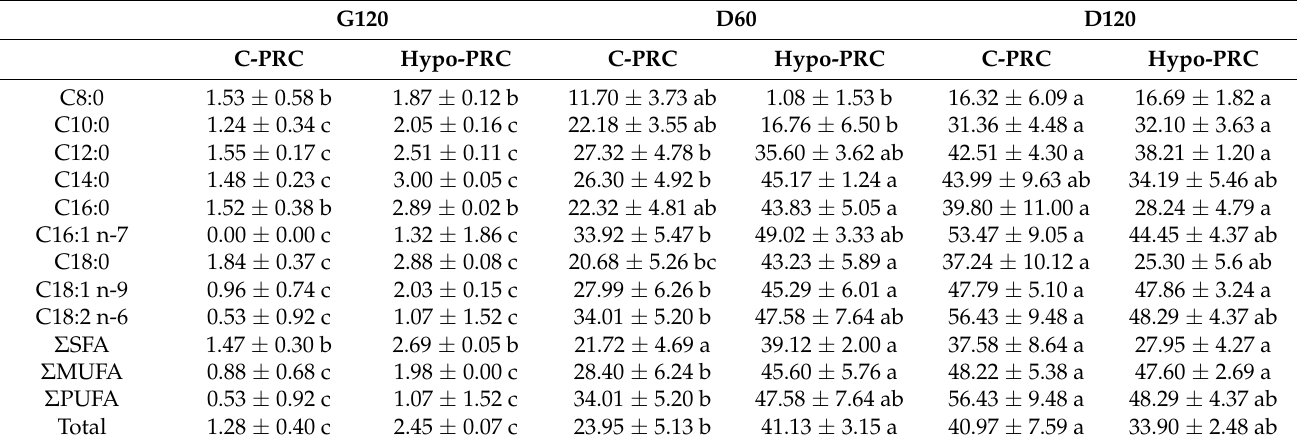
Table 1. Fatty acid bioaccessibility in conventional Parmigiano Reggiano cheese (C-PRC) and hy- posodic Parmigiano Reggiano cheese (Hypo-PRC) at different digestion times. G120 D60